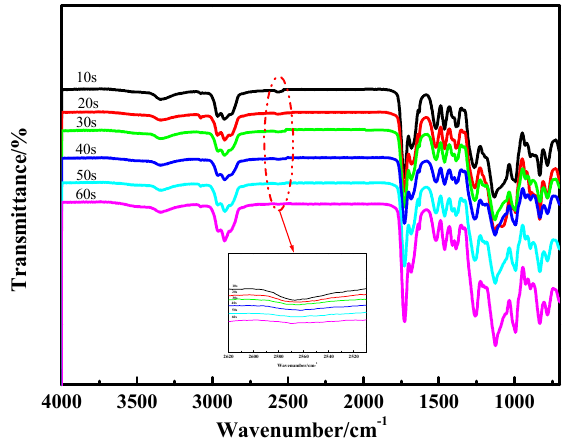
Figure 1. The Fourier transform infrared (FT-IR) spectra of the films cured for various periods. Sulf-PU was the sulf-PU-4 in Table 1 and allyl-terminated hyperbranched